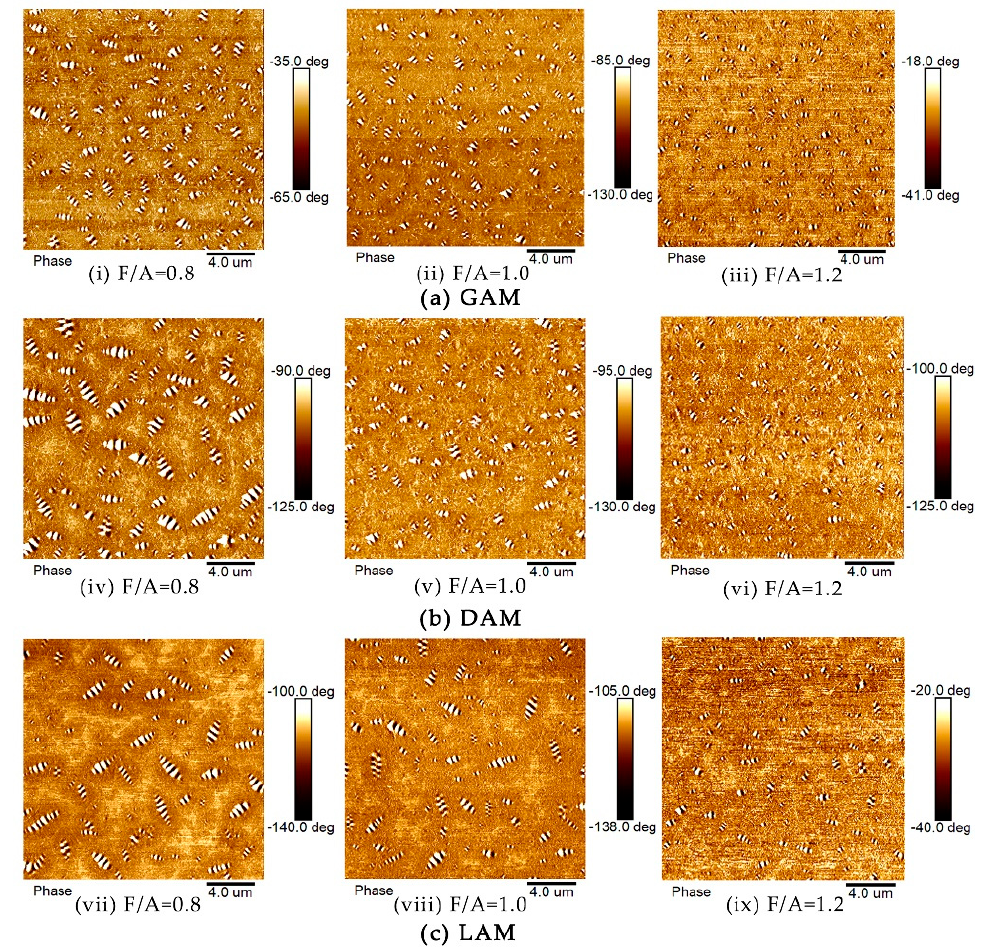
Figure 8. AFM phase morphology images of asphalt mastics. ( a ) GAM; ( b ) DAM; ( c ) LAM.